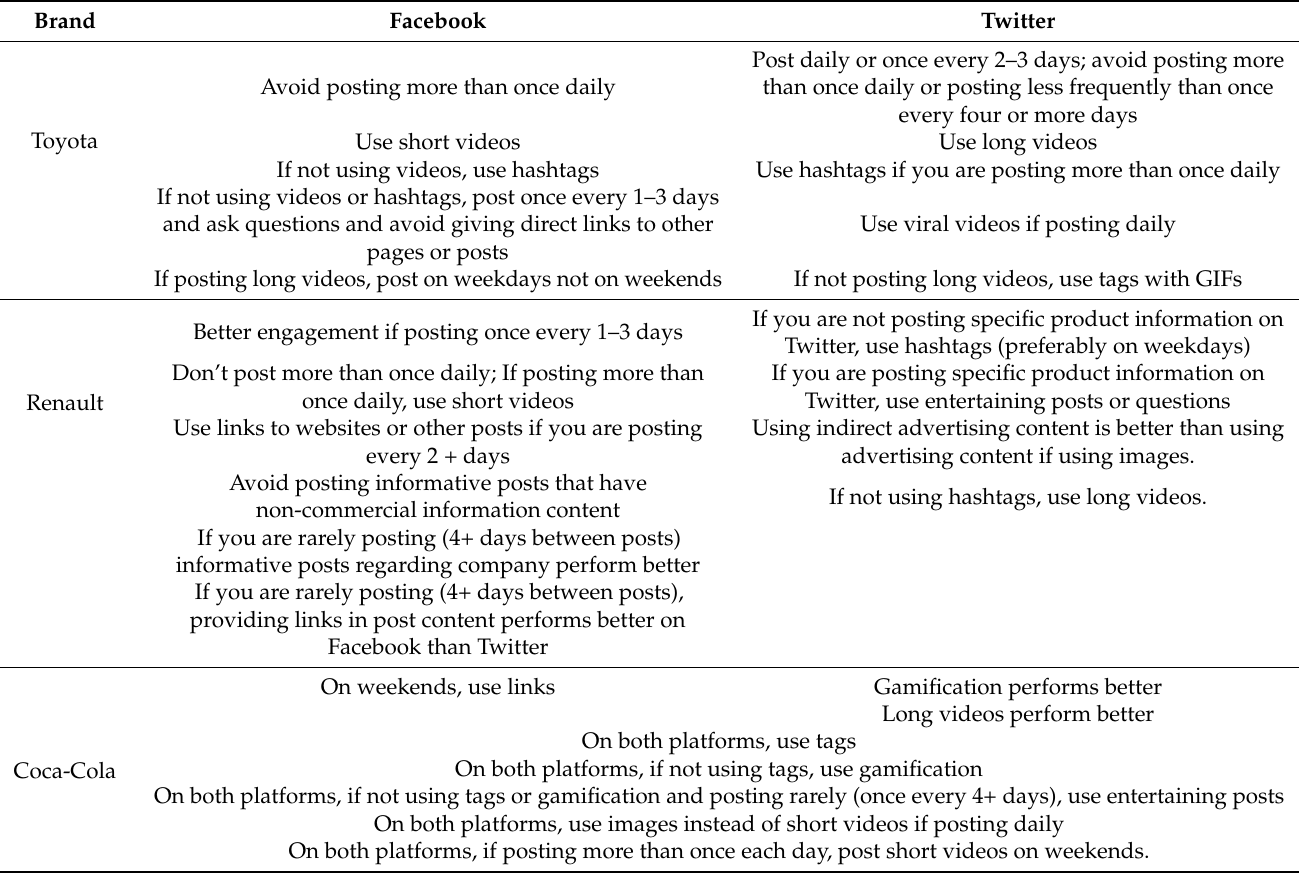
Table 5. Context specific actionable